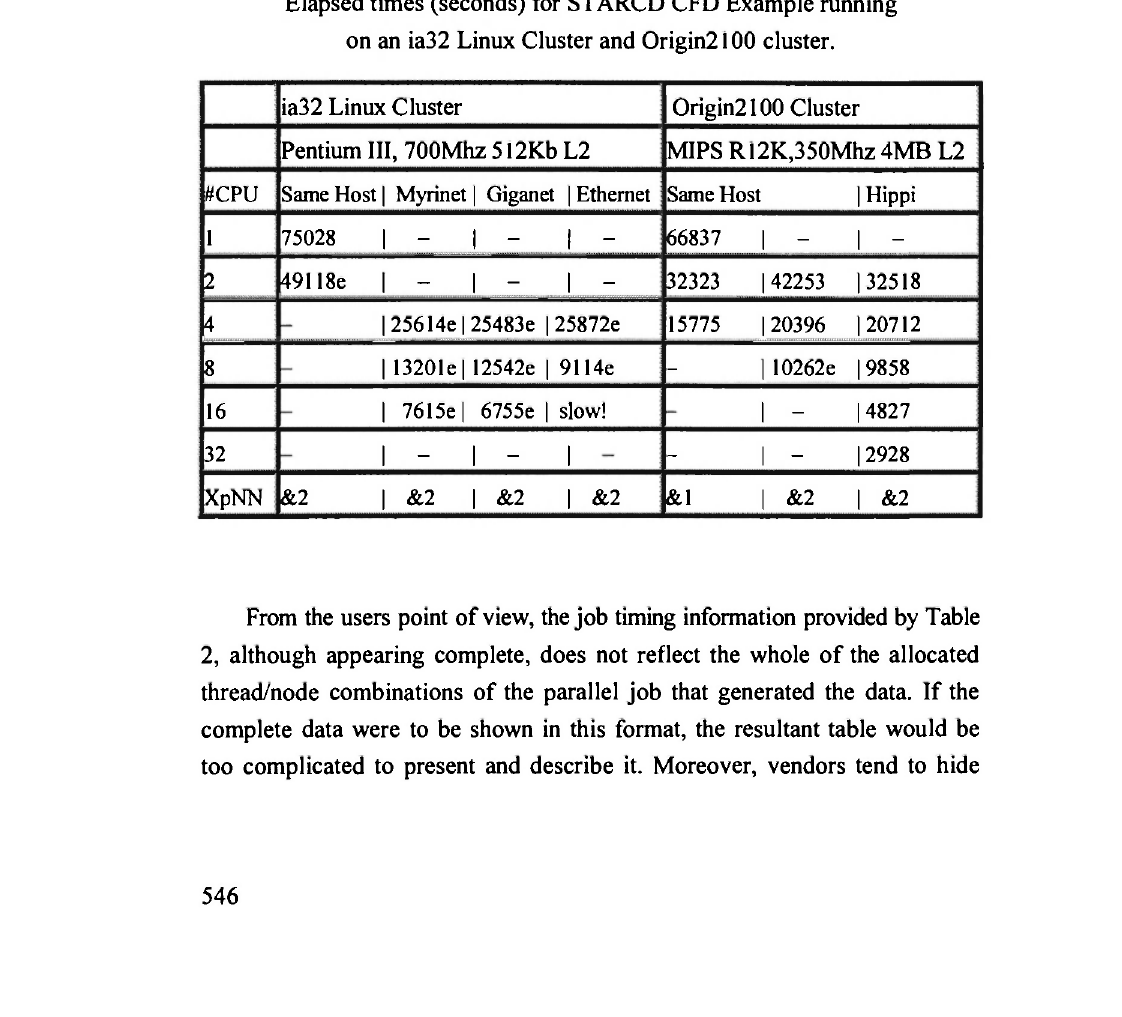
Elapsed times (seconds) for STARCD CFD Example running on an ia32 Linux Cluster and 0rigin2100